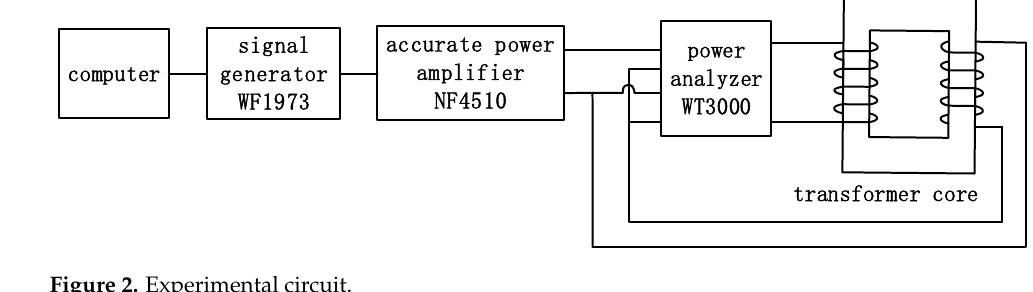
Figure 2. Experimental circuit. Table 1. Parameters of instruments.